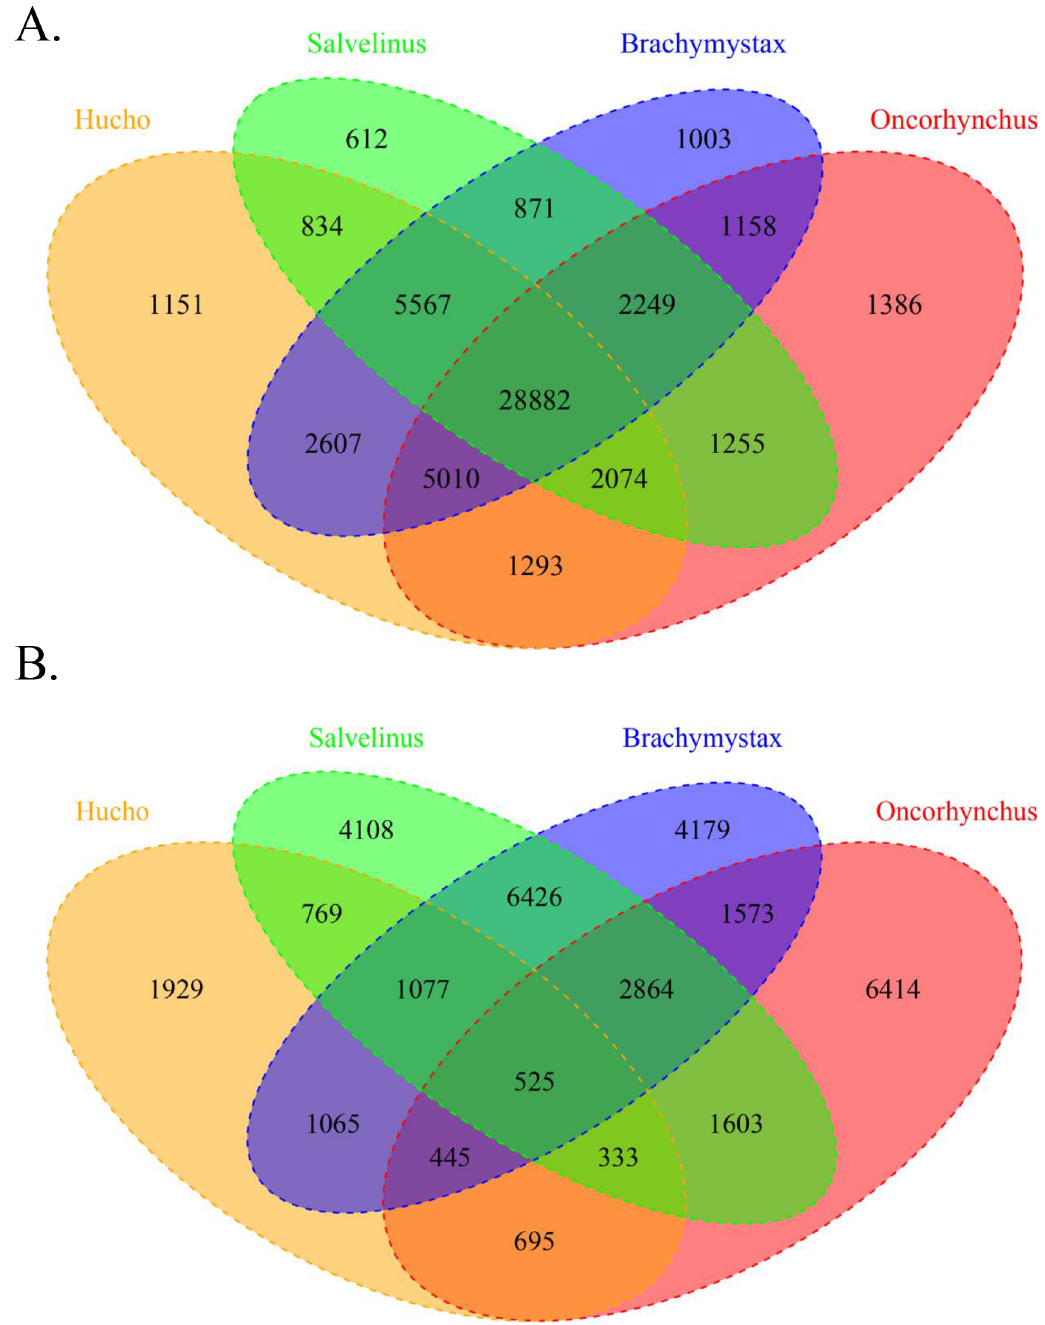
Fig 1. The four-set Venn diagrams of four salmonid genera. Each genus is represented by one color: yellow, Hucho ; red, Oncorhynchus ; green, Salvelinus ; and blue, Brachymystax . The number of shared and unique SNPs is shown in different blocks. (A) The distribution of shared and unique informative SNPs and (B) the distribution of shared and unique polymorphic SNPs among the four